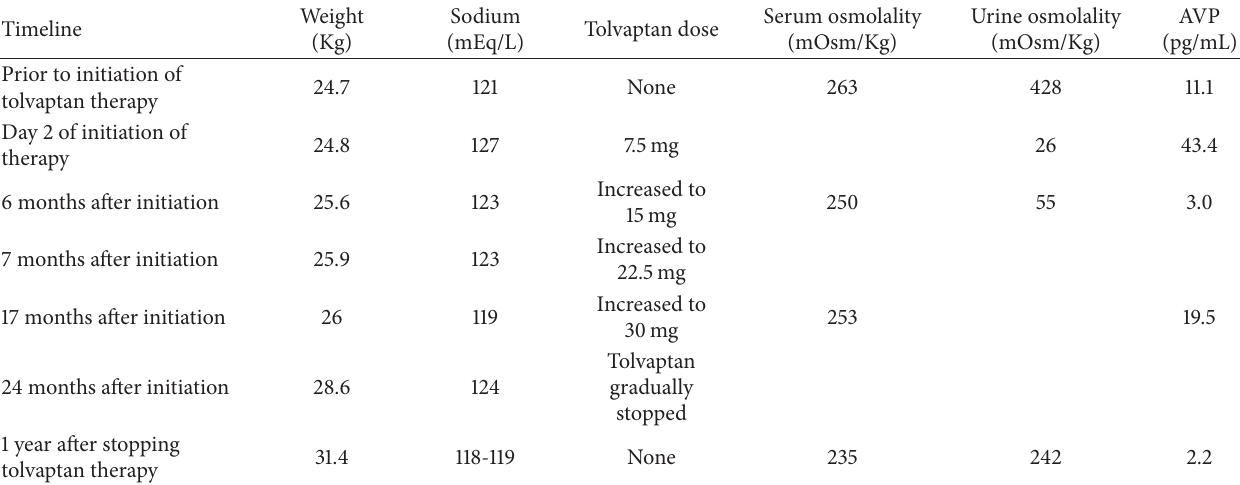
Figure 1: MRI of the brain. (a) Axial FLAIR image demonstrates asymmetric enlargement with abnormal FLAIR hyperintense signal within the right hypothalamus (red circle). (b) Coronal postcontrast T1 weighted image demonstrates no abnormal enhancement within the enlarged right hypothalamus (red arrow). (c) Coronal T2 weighted image demonstrates the mass abutting the lateral margin of the third ventricle and thesuperiormarginoftheopticchiasm(redarrow).(d)Follow-upaxialFLAIRimage,approximately3yearslater,demonstratesnosignificant change in size and abnormal hyperintense signal within the lesion. Table 2: Clinical course with initiation of tolvaptan